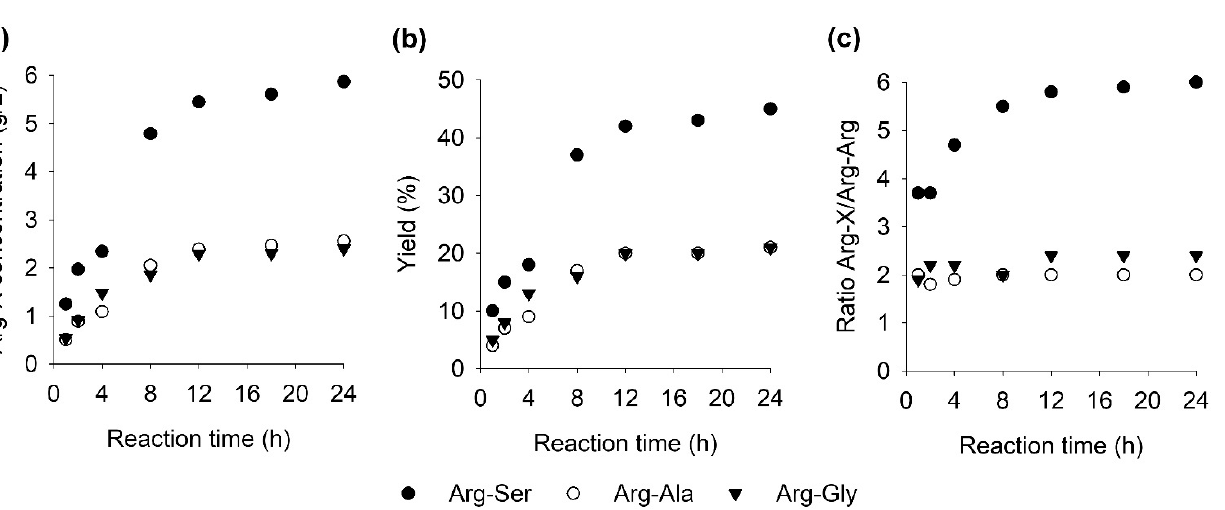
Figure 5. Effect of temperature and buffer pH on Arg-Ser production. Reactions were set up in duplicate; data are presented as mean with error bars representing range.